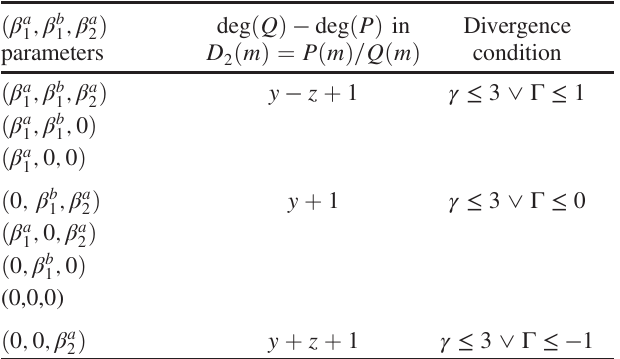
R D m Þ dm for disease 2 ð